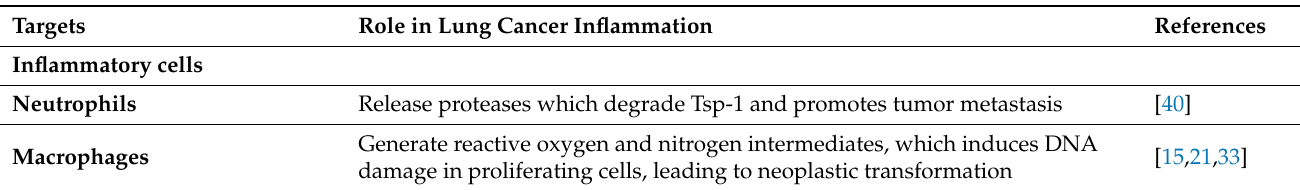
Table 1. List of common targets of inflammation in